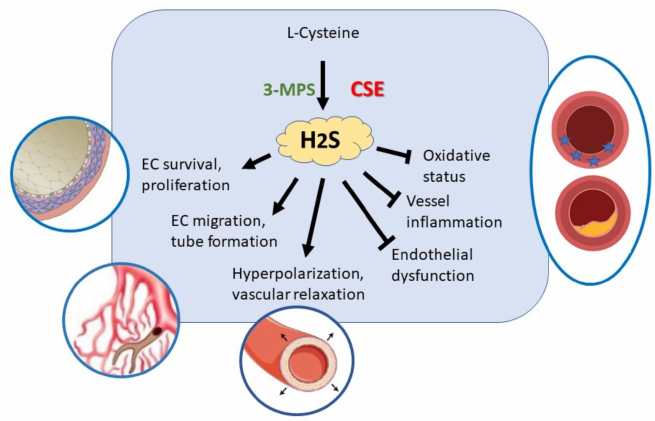
Figure 2. H 2 S exerts autocrine/paracrine actions in vascular endothelial cells in order to maintain their trophism and physiological